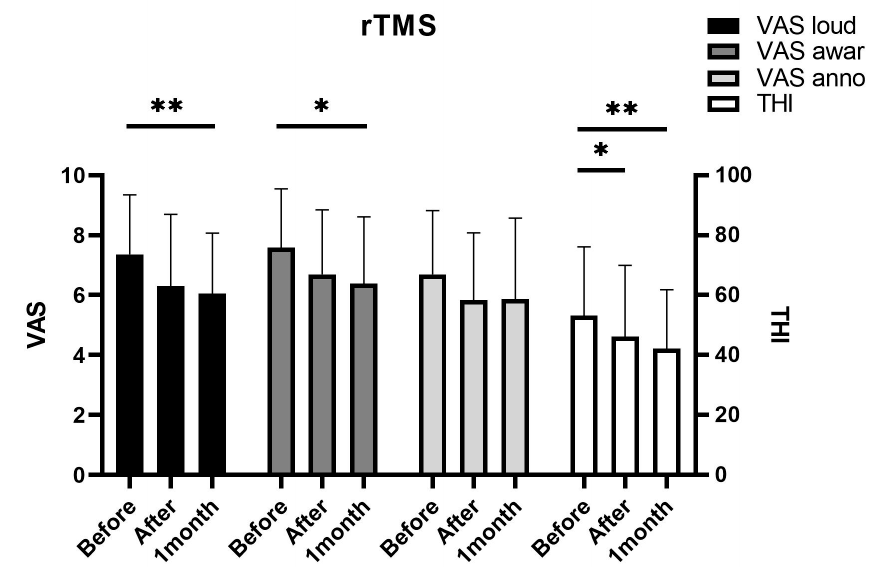
Figure 1. Repetitive transcranial magnetic stimulation (rTMS) rapidly reduces tinnitus symptoms. The rTMS group showed a rapid reduction of tinnitus symptoms evaluated by the visual analog scale and tinnitus handicap inventory survey immediately after treatment and sustained until 1 month after treatment. (* p < 0.05; ** p < 0.01; analyzed using repeated measure analysis of variance). VAS: visual analog scale; THI: tinnitus handicap inventory.